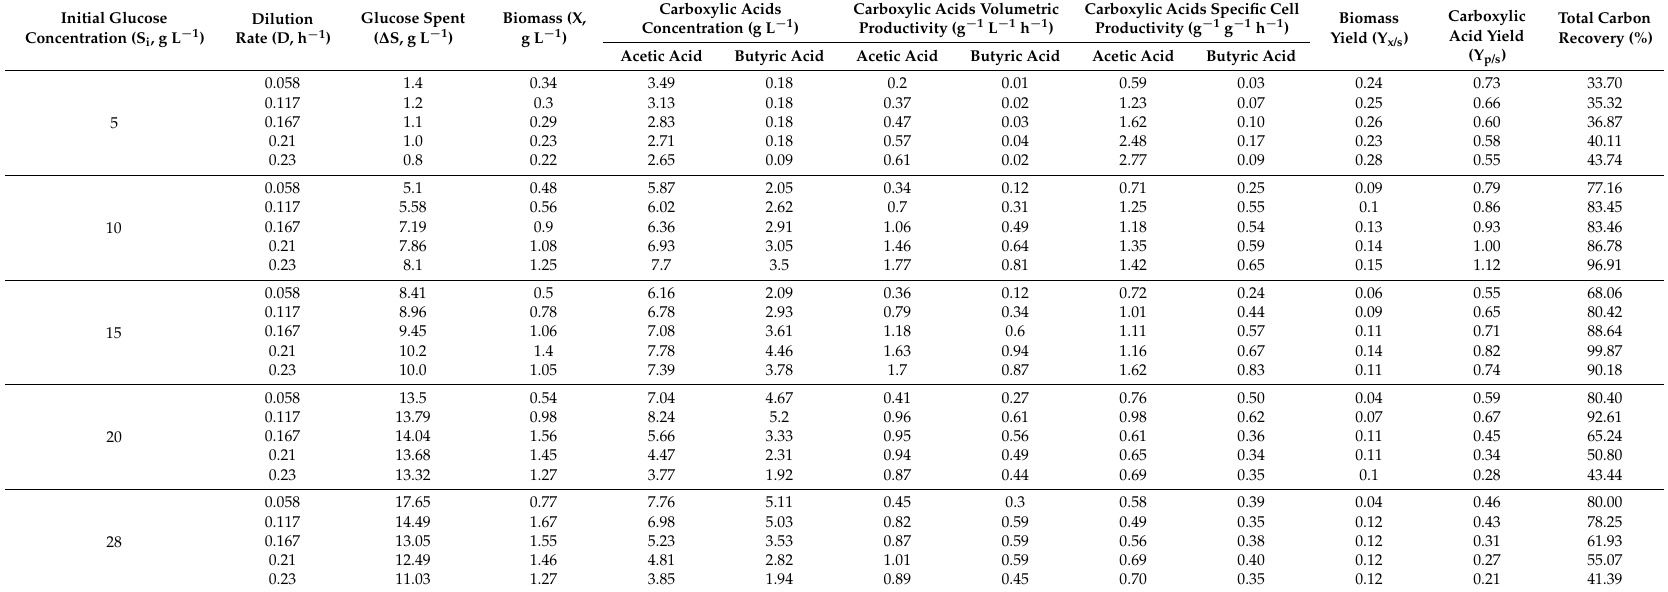
Table 1. Performance of C. butyricum (carboxylic acid productivity, biomass generation, glucose consumption, carbon recovery) in a continuous culture (chemostat)